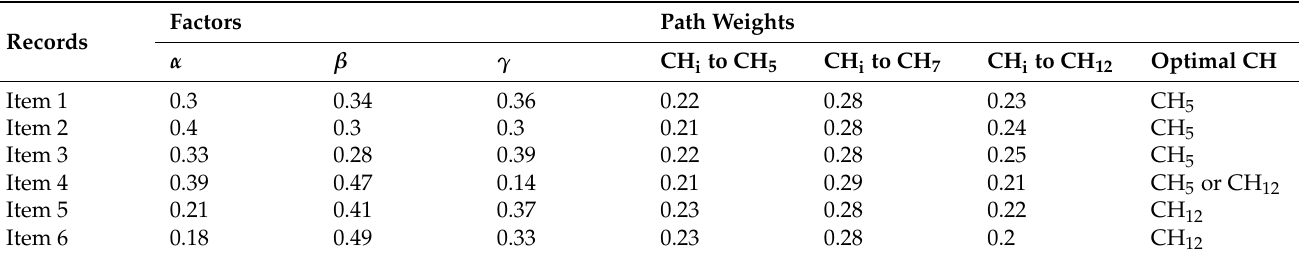
Table 2. Path weights under different factors.